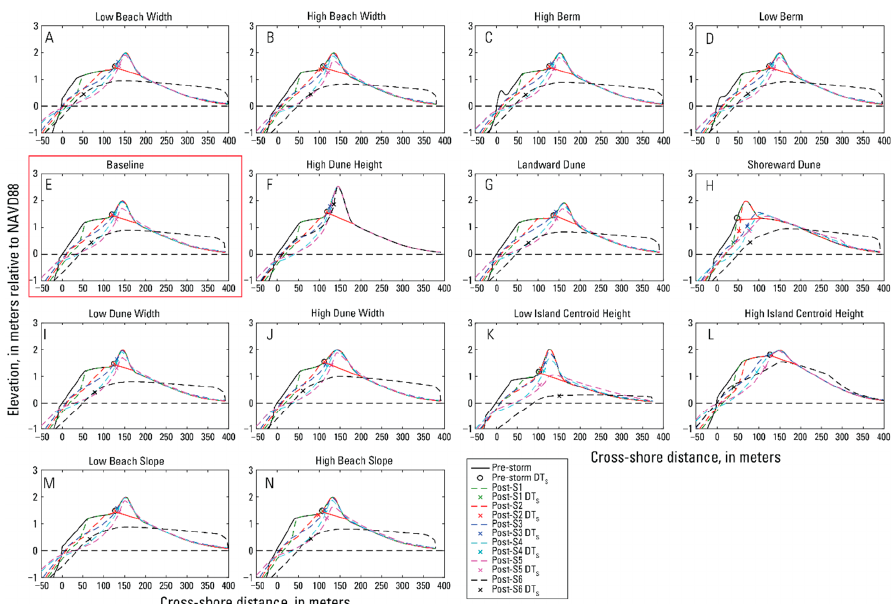
Figure 7. 2D pre- and averaged post-simulation profiles for all 6 storm scenarios with alongshore averaged shoreward dune toe position (DT s ) identified.( A ) low beach width case, ( B ) high beach width case, ( C ) high berm height case, ( D ) low berm height case, ( E ) baseline case, ( F ) high dune height case, ( G ) landward positioned dune case, ( H ) shoreward positioned dune case, ( I ) low dune width case, ( J ) high dune width case, ( K ) low island centroid height case, ( L ) high island centroid height case, ( M ) low beach slope case, and ( N ) high beach slope case. Horizontal dashed line denotes the 0 m elevation line for reference. Red line indicates dune footprint area examined in post-storm analyses for dune volume and width changes.